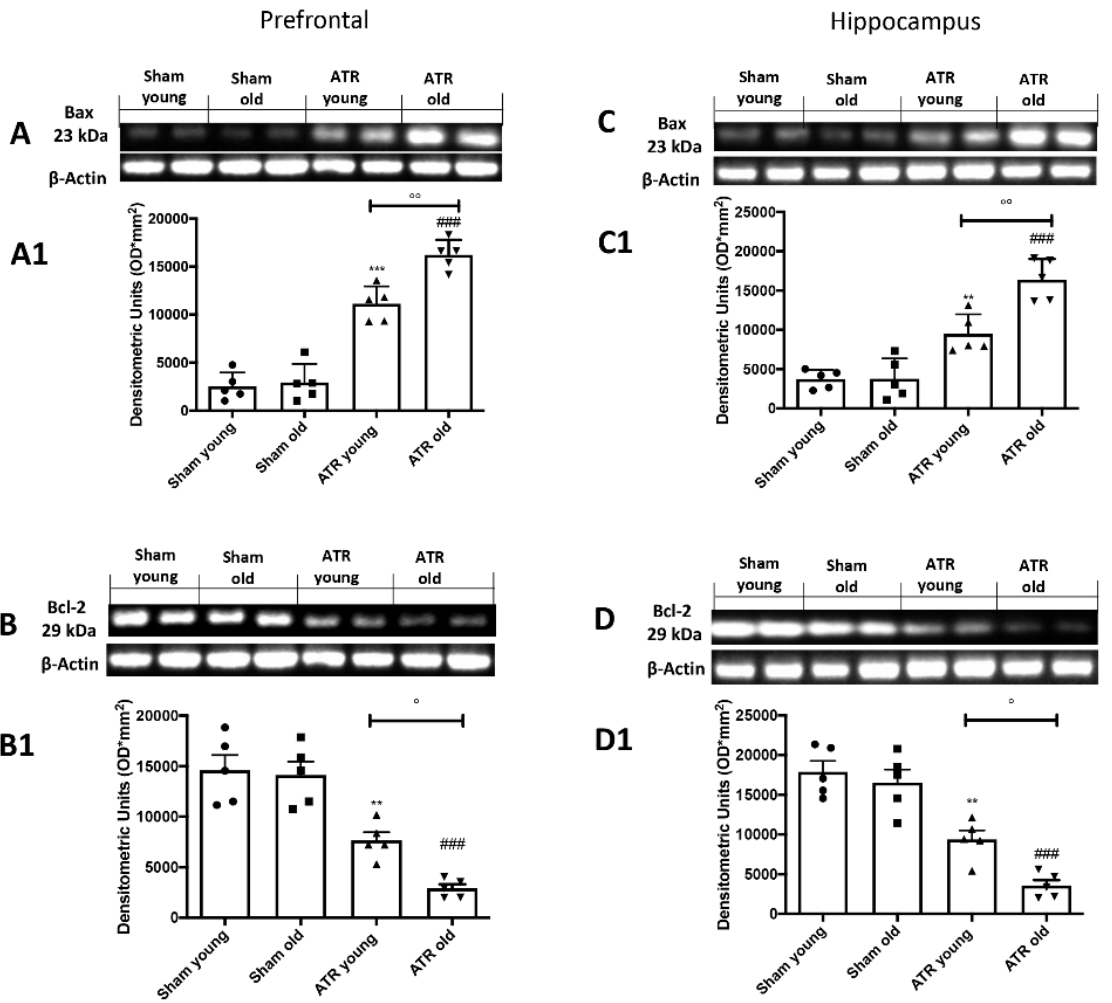
Figure 7. Impact of ATR inhalation on brain apoptosis. Western blots and respectively quantification of Bax in prefrontal cortex ( A , A1 ) and hippocampus ( C , C1 ) and Bcl-2 in prefrontal cortex ( B , B1 ) and hippocampus ( D , D1 ) We found that those aged mice are more subjected to brain apoptosis compared to young mice after 28 days of ATR inhalation. Data is expressed as the mean ± SEM of n = 5 animals for each group. ** p < 0.01 vs. Sham young; *** p < 0.01 vs. Sham young; ### p < 0.001 vs. Sham old; ◦ p < 0.05 ATR old vs. ATR young; ◦◦ p < 0.01 ATR old vs. ATR young.